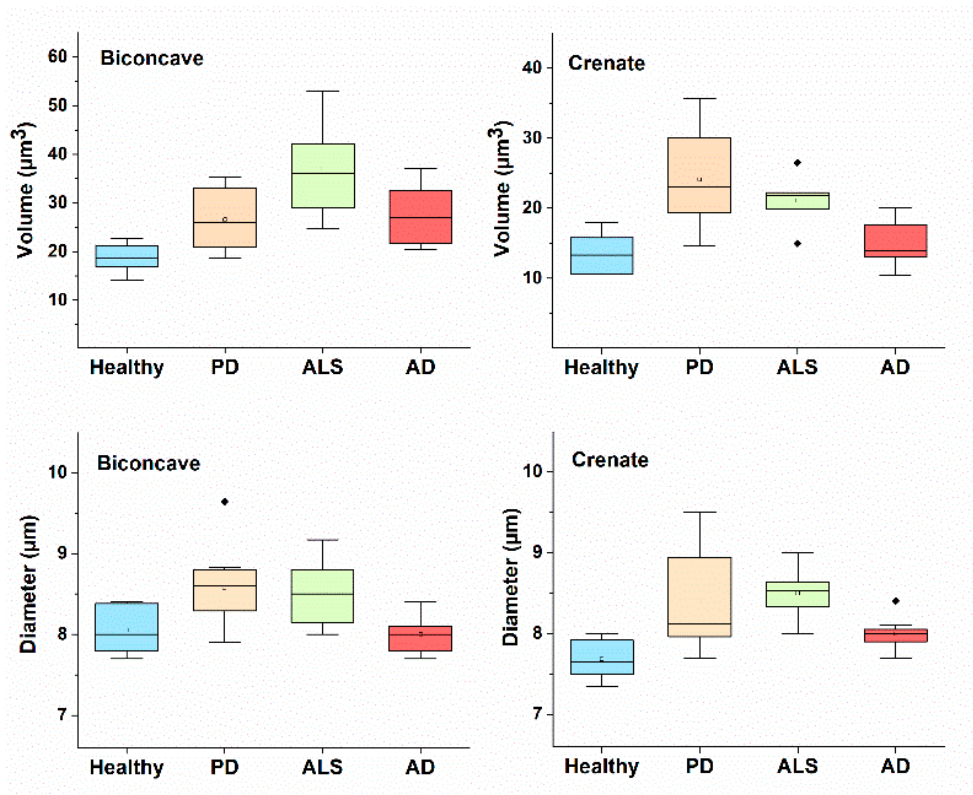
Figure 6. Diameter and volume of biconcave and crenate shape of PD, AD and ALS compared to healthy RBCs. Mean values and SD.